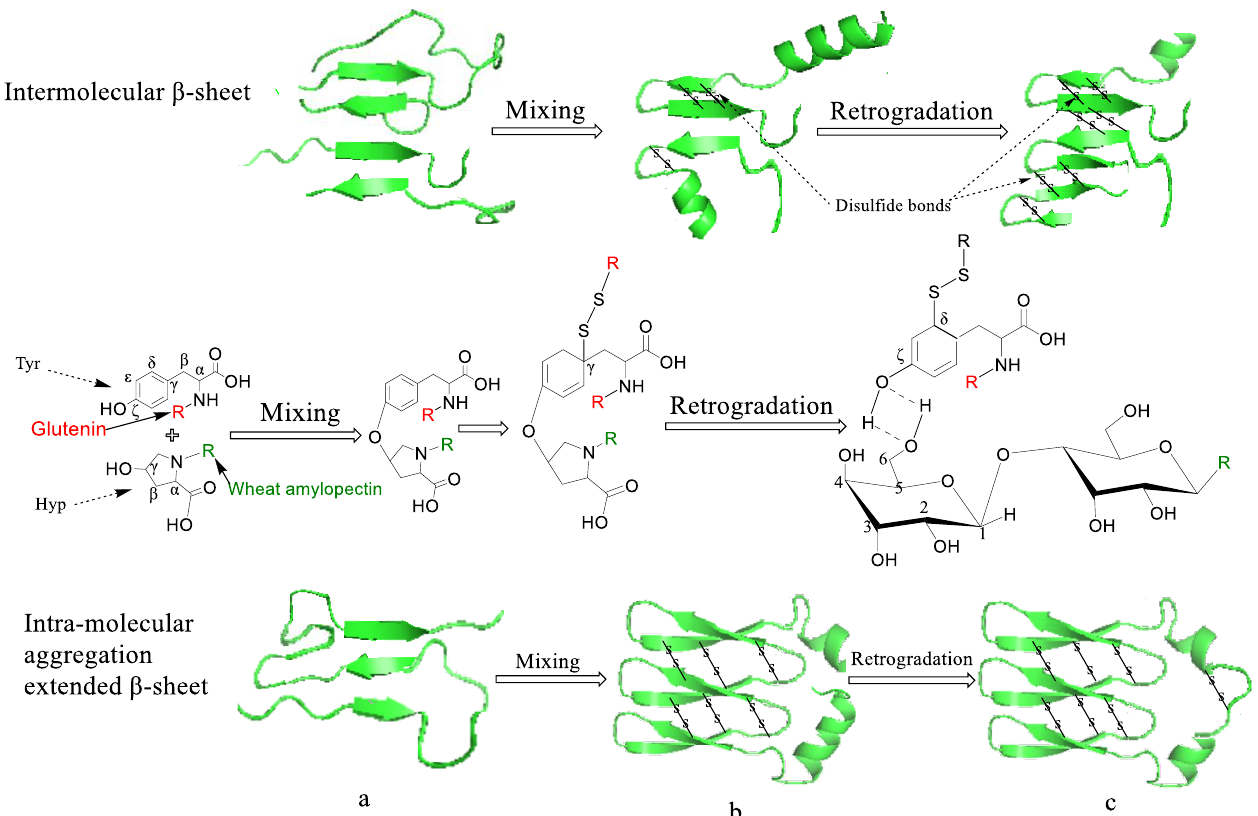
Figure 4. Proposed schematic diagram of disulfide bond formation during the mixing and retrogra- dation of wheat amylopectin + alkali-soluble glutenin. a. initially secondary structure of alkali-sol- uble glutenin, b. secondary structure of alkali-soluble glutenin being mixed with wheat amylopec- tin, c. secondary structure of alkali-soluble glutenin mixed with wheat amylopectin after retrogra- dation.